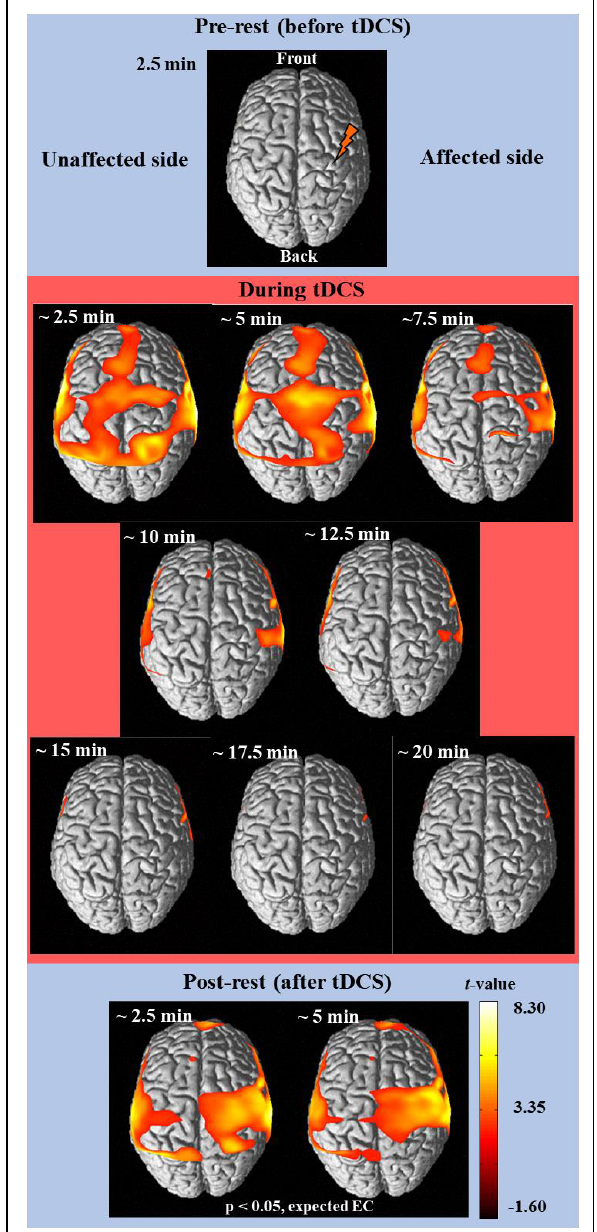
Figure 2. The average cortical activation maps of 26 subjects analyzed by using the NIRS-SPM software before (prerest), during, and after (post-rest) tDCS